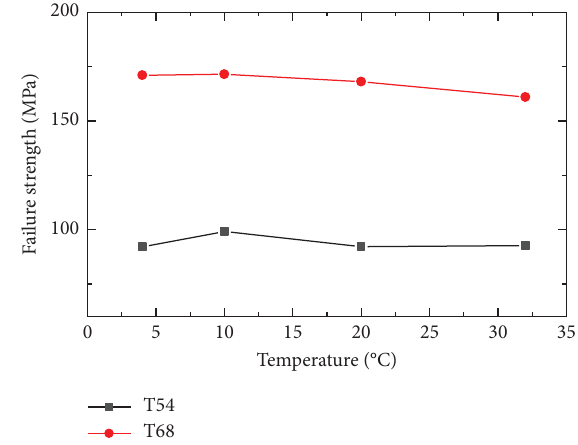
Figure 8: Failure strength vs.